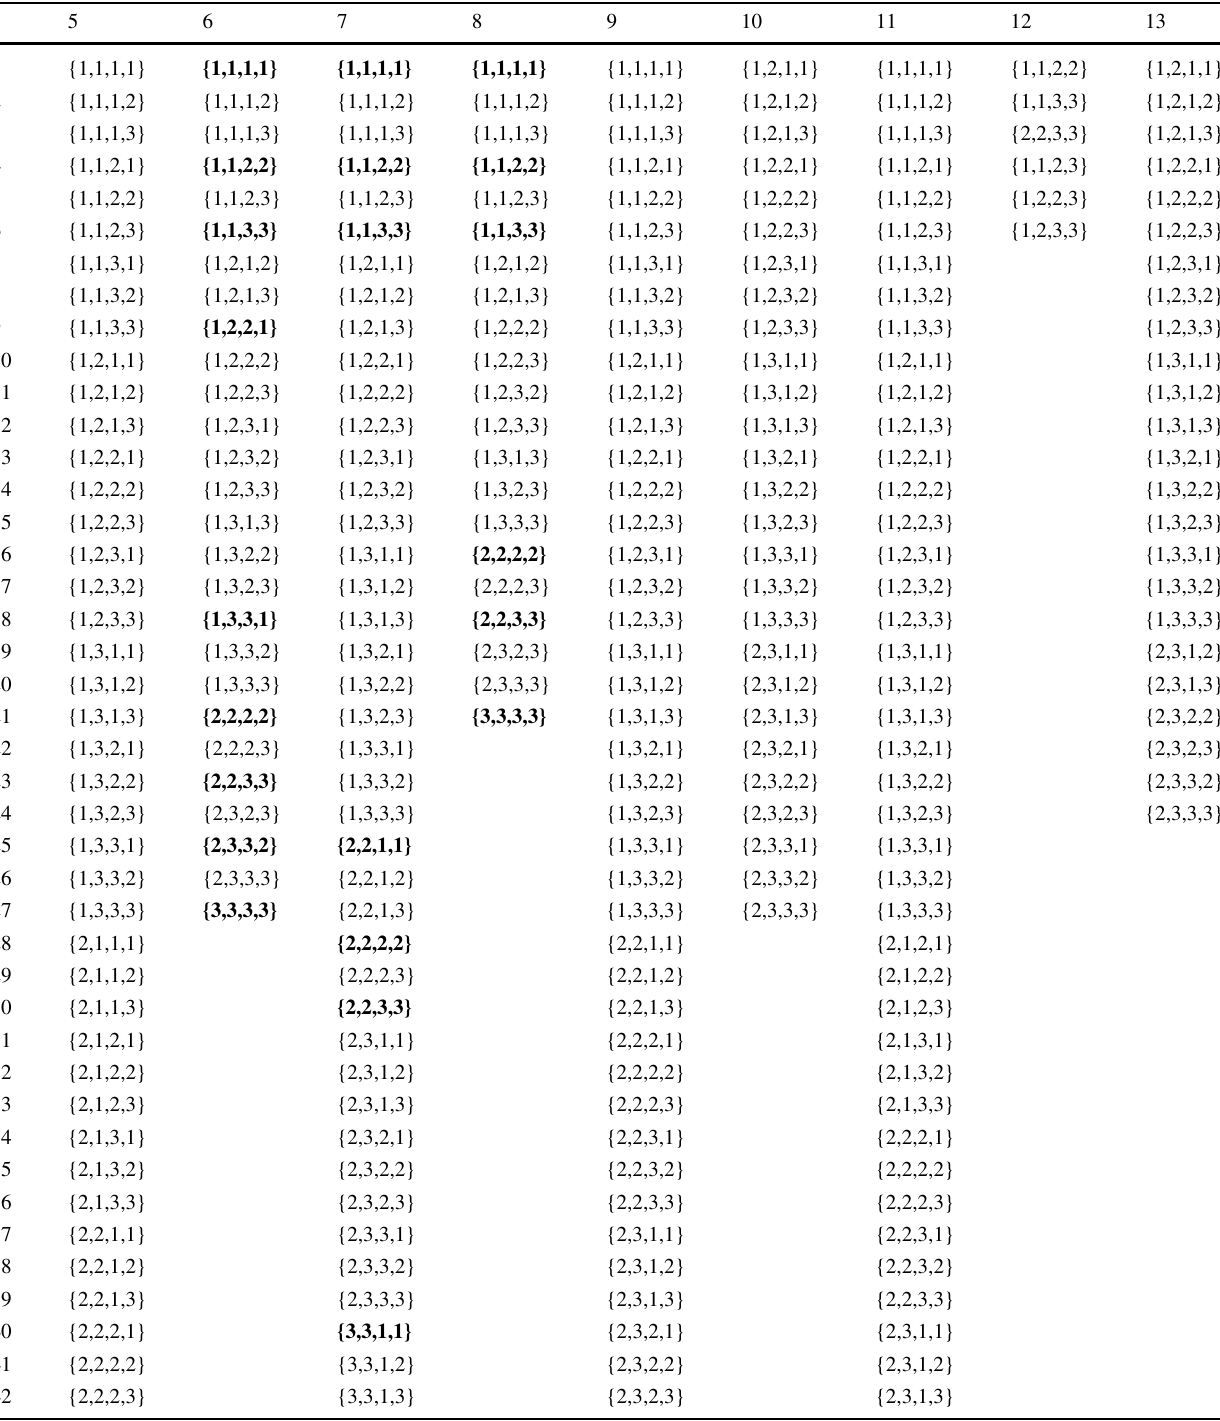
Table 16 Independent WCs in each 4F category. Same notation as in